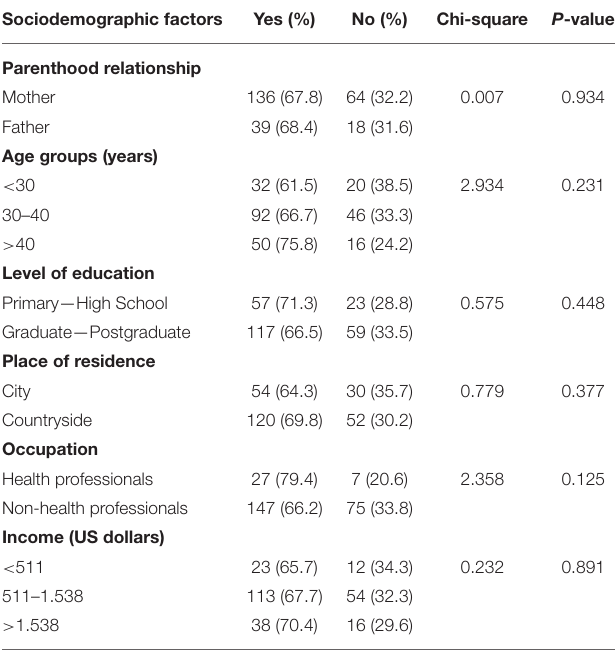
Table 5 indicates the responses of parents regarding